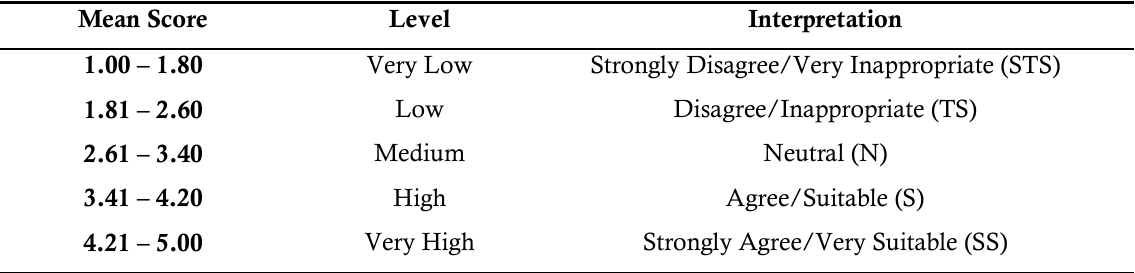
Table 1 . Mean Value and Questionnaire Interpretation